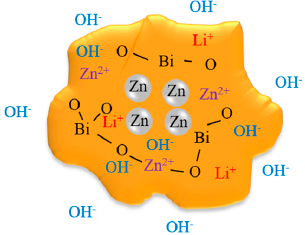
Figure 1. Schematic illustration of the gel-forming bismuth oxide containing zinc–glass composite. The glass matrix consists of Bi 2 O 3 -Li 2 O-ZnO. The glass matrix consists of Bi 2 O 3 -Li 2